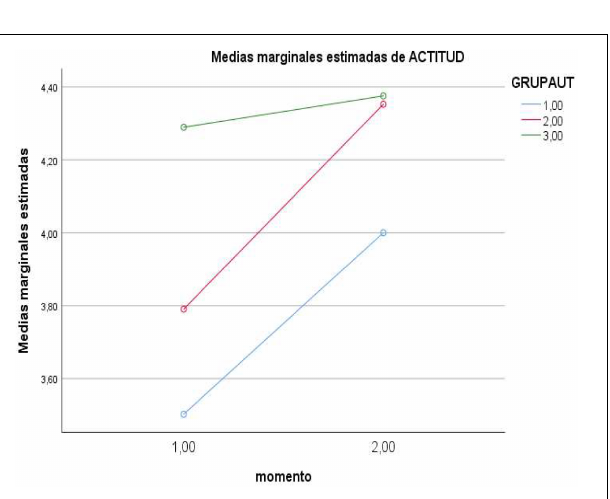
FIGURE 3 | Effects of Moment × Level of regulation on attitudes (1 = low; 2 = medium; 3 = high).